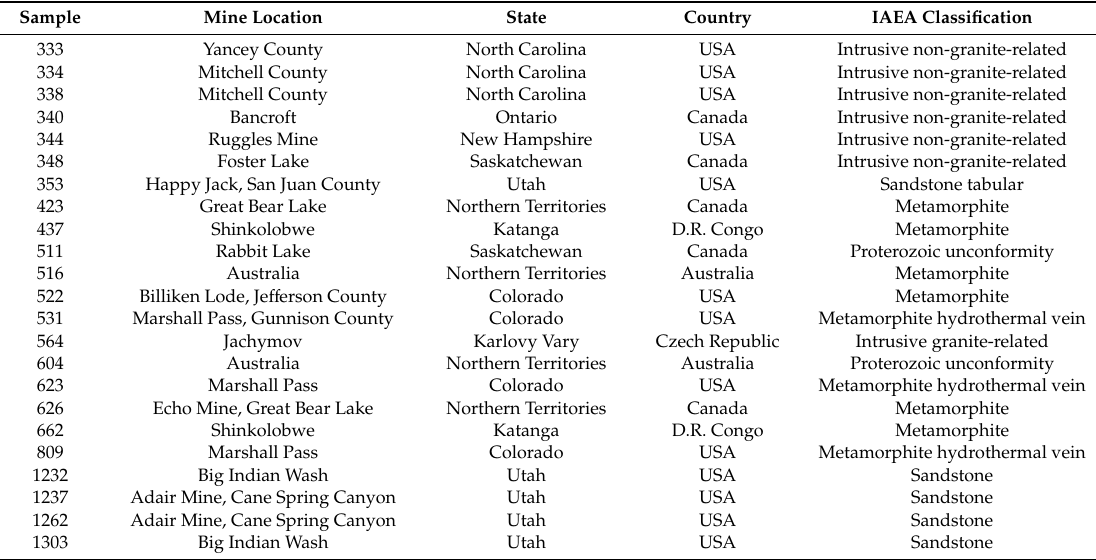
Table 1. Location and deposit classification of uraninite samples (n =